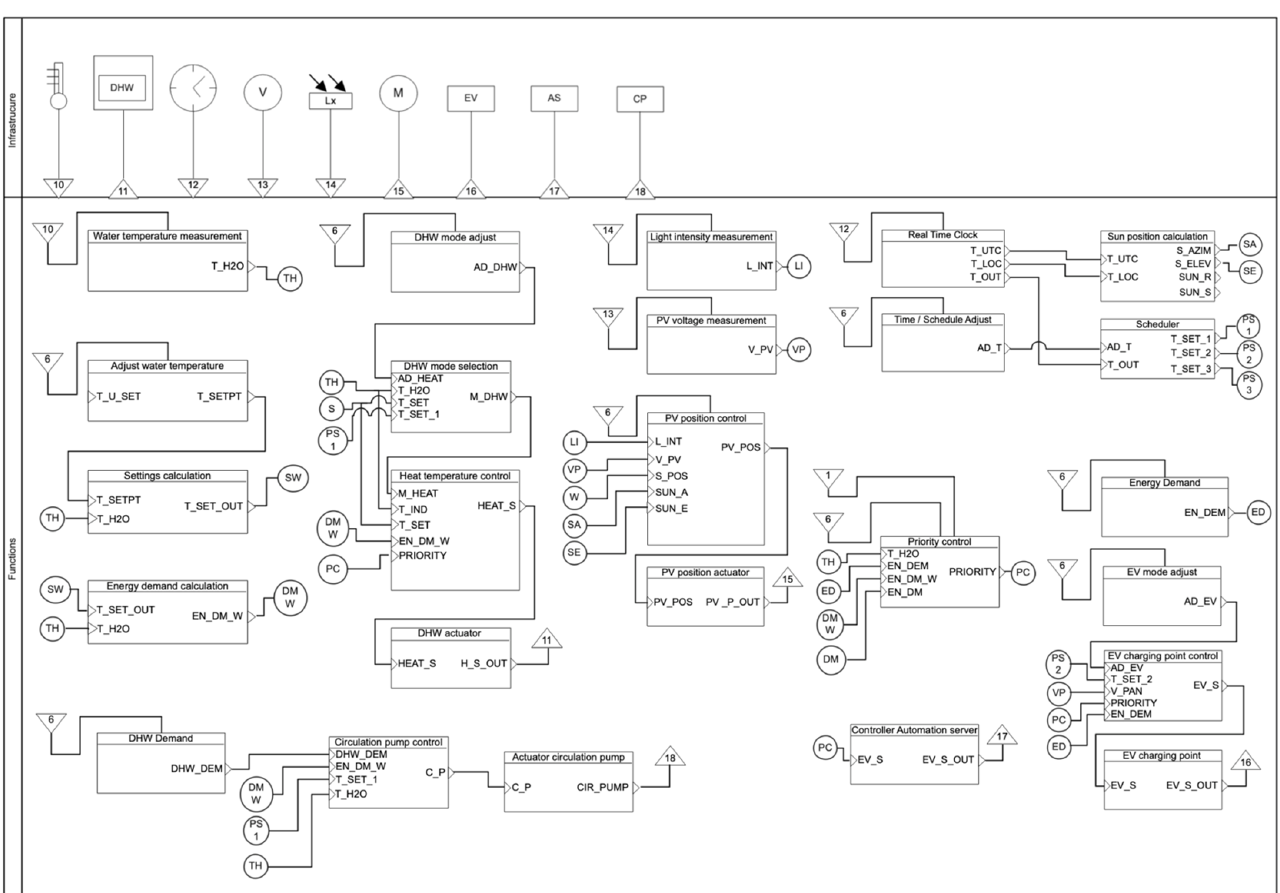
Figure 3. A functional diagram of control and energy management system for small prosumer installation organized according to the EN 15232 standard BACS efficiency class A with additional functions proposed in the paper—part 2.